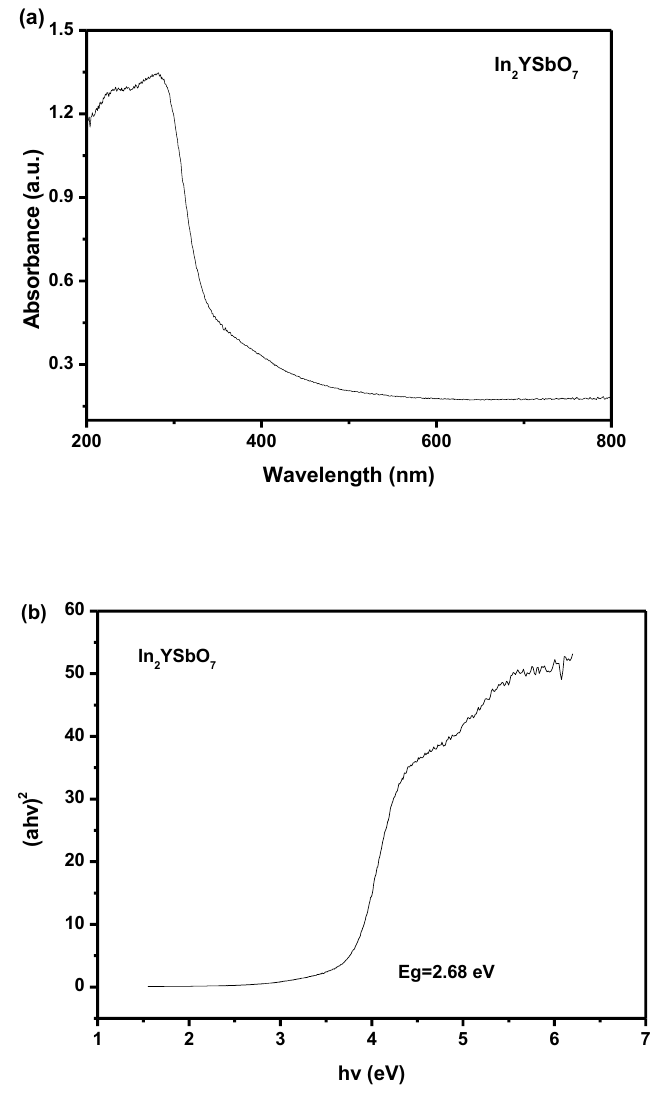
Figure 6. ( a ) UV–vis diffuse reflectance spectra of In 2 YSbO 7 ; ( b ) Plot of ( α h ν ) 2 versus h ν for In 2 YSbO 7 .